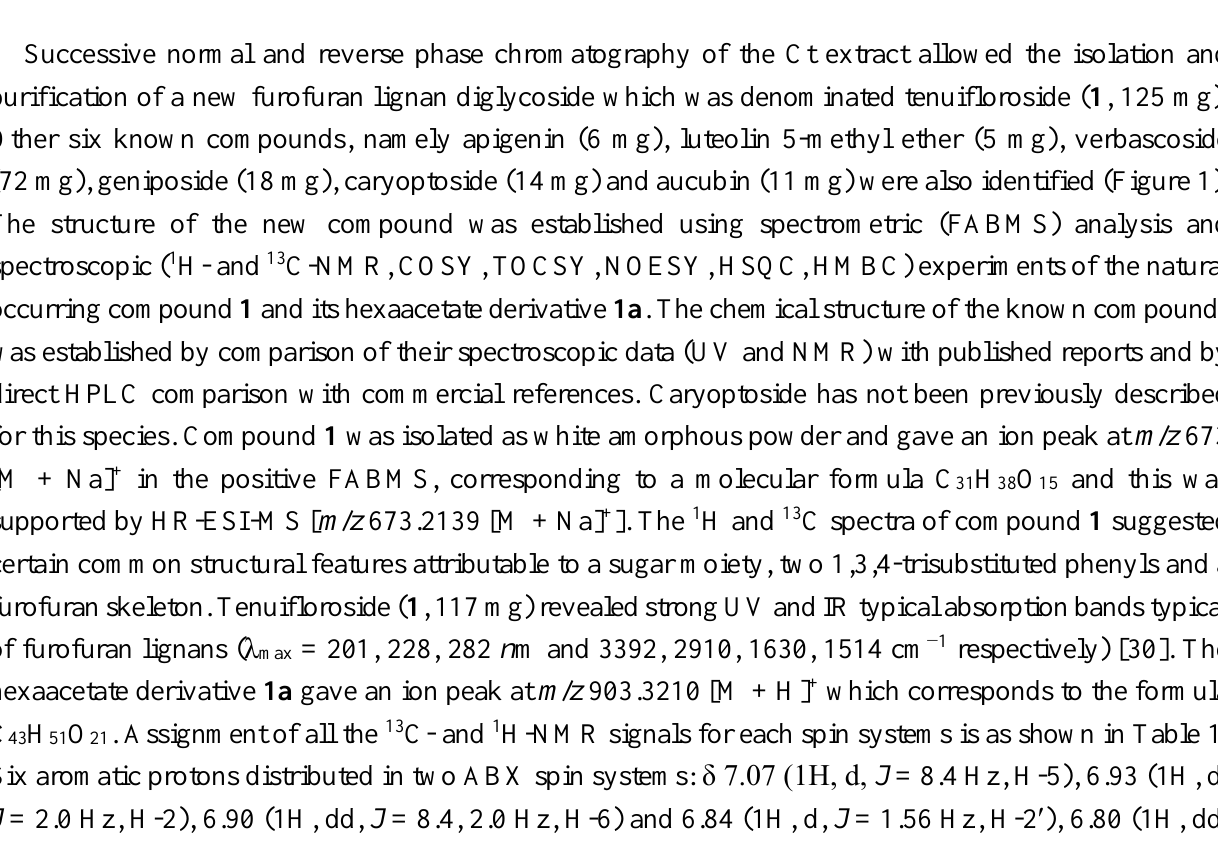
Figure 6. Effect produced by different doses (50, 100, 500 and 750 mg/kg, p.o. ) of Ct extract from C. tenuiflora (Ct) on immobility time in the FST. The results are presented as means ± SD. * p < 0.05, as compared with the control group. (ANOVA one way following by Dunnet test); n = 6 mice per group. IMI = Imipramine, Veh = Tween 20,